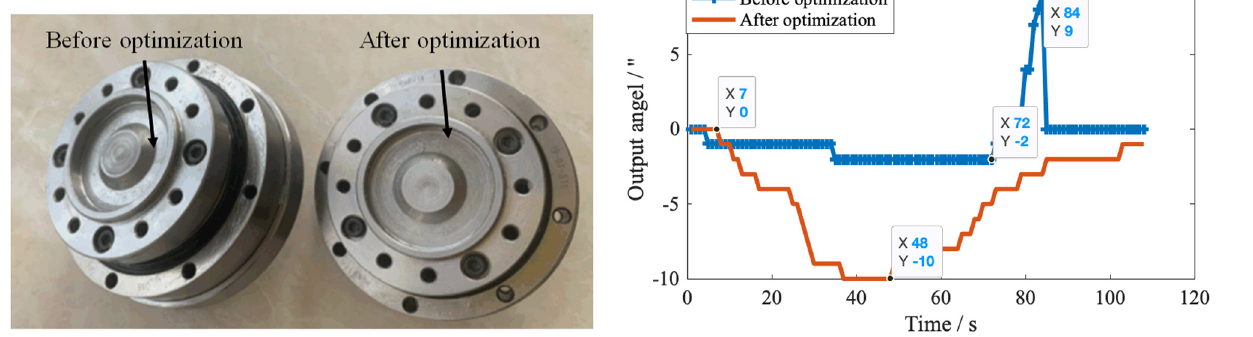
Figure 14: Backlash test results of